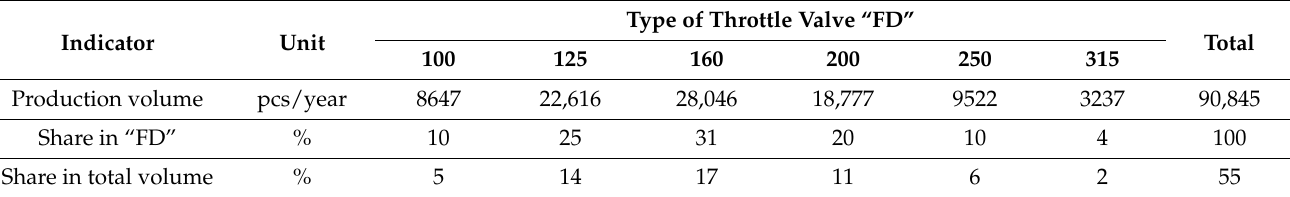
Table 1. Production volumes of individual types of throttle valves type FD.